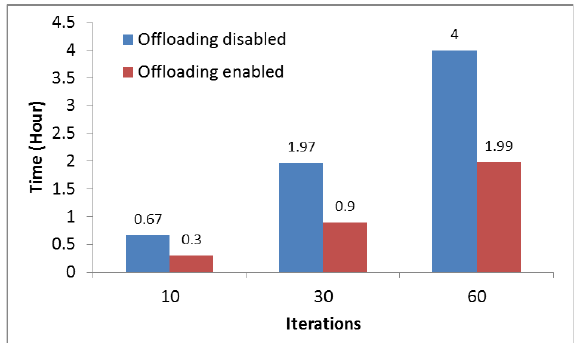
Figure 11: Execution time of AT on 104×23×24